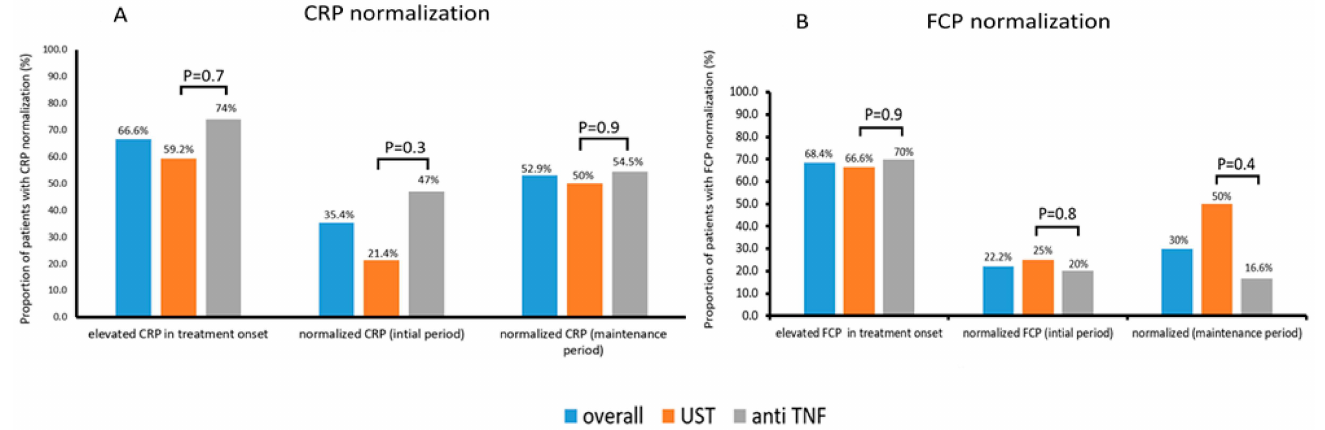
Figure 3. Biomarker normalization. The proportion of patients with CRP normalization (A) (CRP serum concentration levels less than normal range as per cut-off used in the corresponding institu- tions) and FCP normalization (B) (FCP < 250 µg/g); CRP, C-reactive protein; FCP, Fecal Calprotectin; UST, ustekinumab; anti-TNF, anti-tumor necrosis factor.